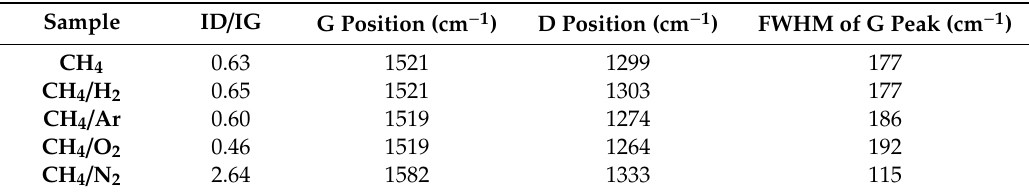
Table 2. Analysis of Raman spectra of produced carbon flakes.